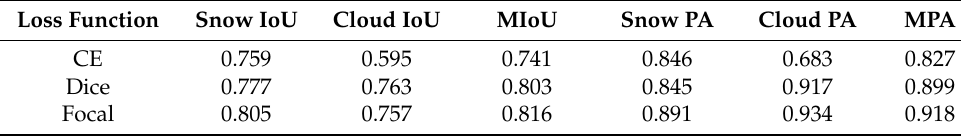
Table 5. Comparison of model test accuracy under different loss functions.